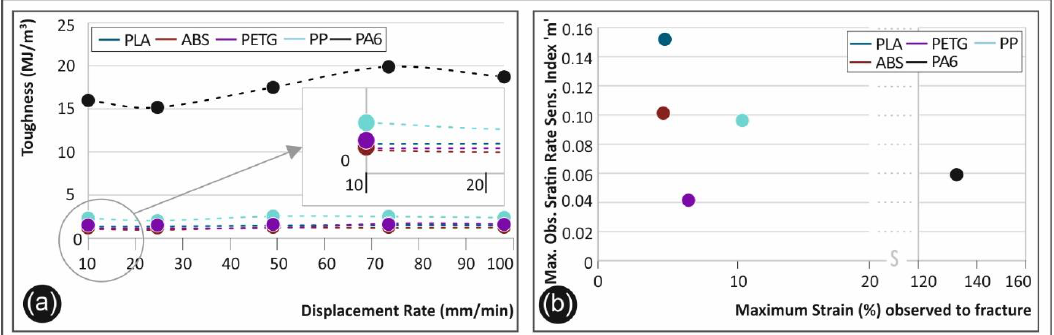
Figure 14 . ( a ) Toughness (MJ/m 3 ) to the displacement rate (mm/min) for all five tested polymers, and ( b ) maximum strain rate sensitivity index “m” calculated to the corresponding strain (%) of the specimen for all five polymers tested.